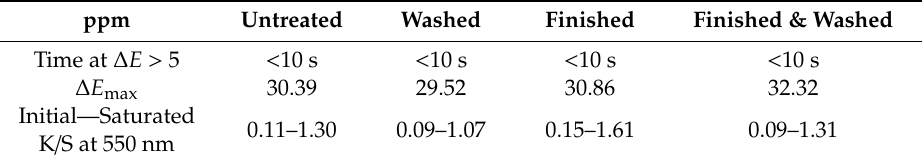
Table 5. Color change data according to washing and finishing of the printed sensor.